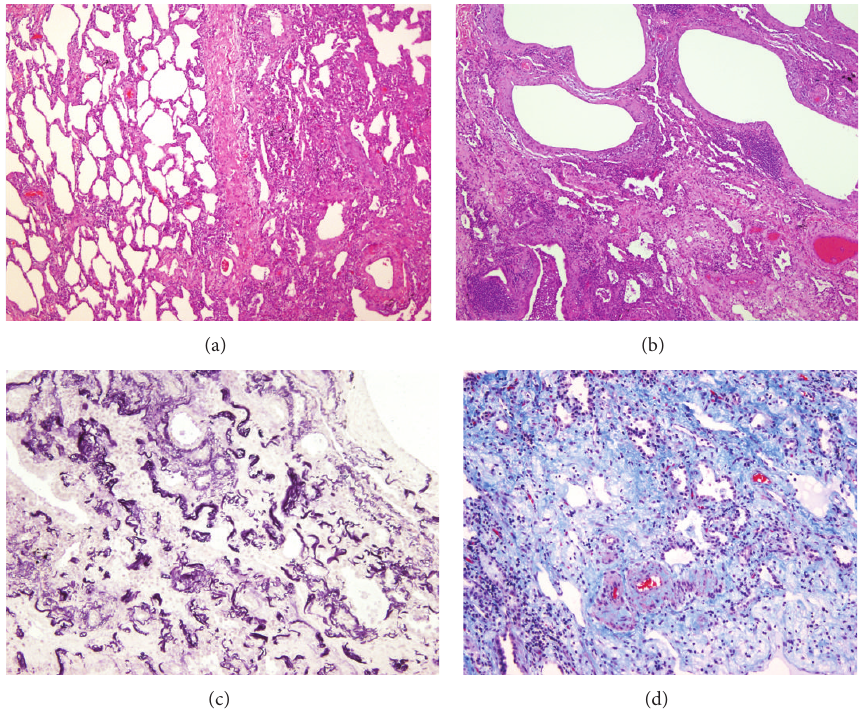
Figure 2: Histological features of Case 1 (surgical lung biopsy specimen). (a) Microscopic image showing sparsely cellular dense connective tissue with small vessels. Hematoxylin-eosin (HE) 100x. (b) At high power inset in area of dense fibrosis with multiple capillaries, without inflammatory infiltrate appearance. HE 250x. (c) Microscopic image shows the presence of abundant elastic fibers irregularly grouped. Orcein stain 100x. (d) Microscopic appearance of the image (b), visualized by fluorescence. Elastic fibers, which shine for eosin autofluorescence, can be observed. Fluorescence microscopy 250x.